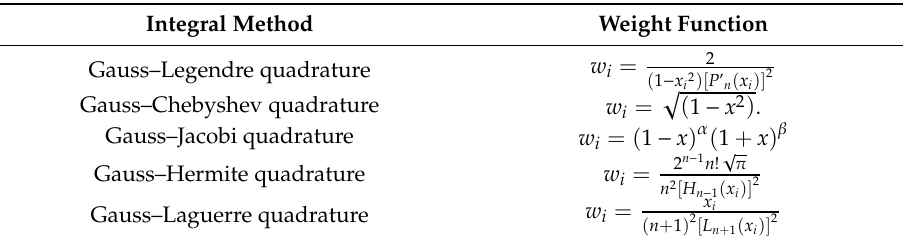
Table 1. Weight function of integral